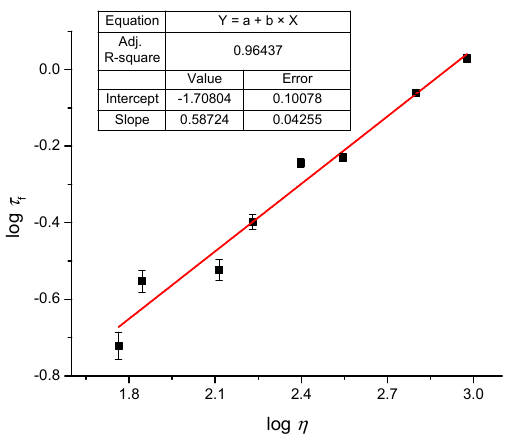
Figure 7. Plot of log τ f vs . log η for dU-BZ.